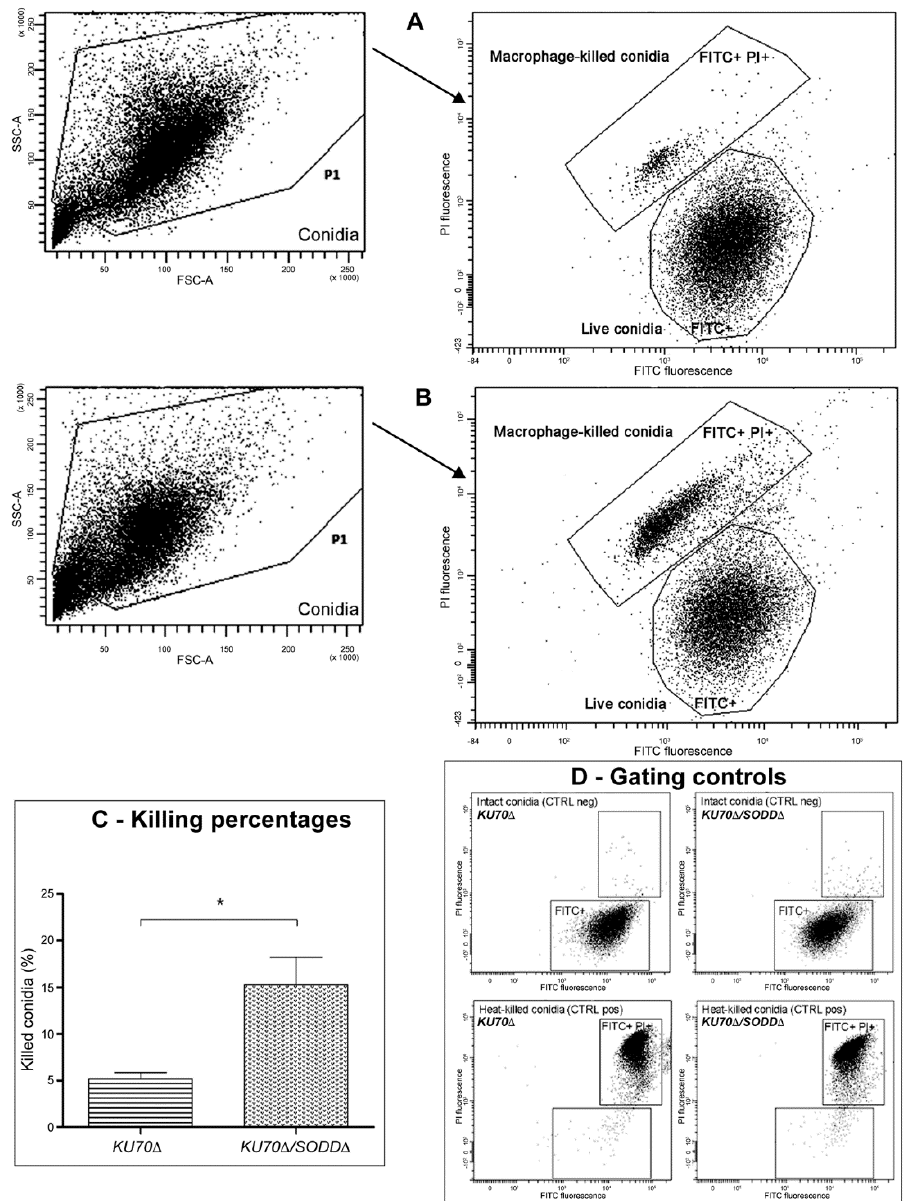
Figure 5. Flow cytometry analysis of the macrophage-mediated killing of conidia of SODD defective mutant ( KU70Δ/SODDΔ ) and its parent strain ( KU70Δ ) . After 6 h of coincubation with macrophages, fluorescein isothiocyanate (FITC)-labeled conidia were released from macrophages by lysis of the cells, stained with propidium iodide (PI), and analyzed by flow cytometry. On the forward scatter (FSC) vs. side scatter (SSC) histogram plot, conidia with values lower than 50 were excluded from selection. Conidia were then gated on the scatter plot of FITC against PI fluorescence to define populations: FITC+ signals correspond to live conidia, while double-positive signals (FITC+ PI+) relate to macrophage- killed conidia. The baseline of positivity of each marker was defined using non-labeled conidia (not shown). ( A ): plots corresponding to the parent strain KU70Δ. ( B ): plots corresponding to the double mutant KU70Δ/SODDΔ . The plots are derived from one experiment representative of the other experiments. ( C ): the percentage of killing was defined as the number of macrophage-killed conidia to the total number of macrophage-released conidia × 100; killing percentage data were collected from three independent experiments; error bars correspond to the standard error of the mean; *, p < 0.05. ( D ): negative control (fresh live conidia) and positive control (heat-killed conidia) were run to define population border- lines (please see Results section for further explanation).